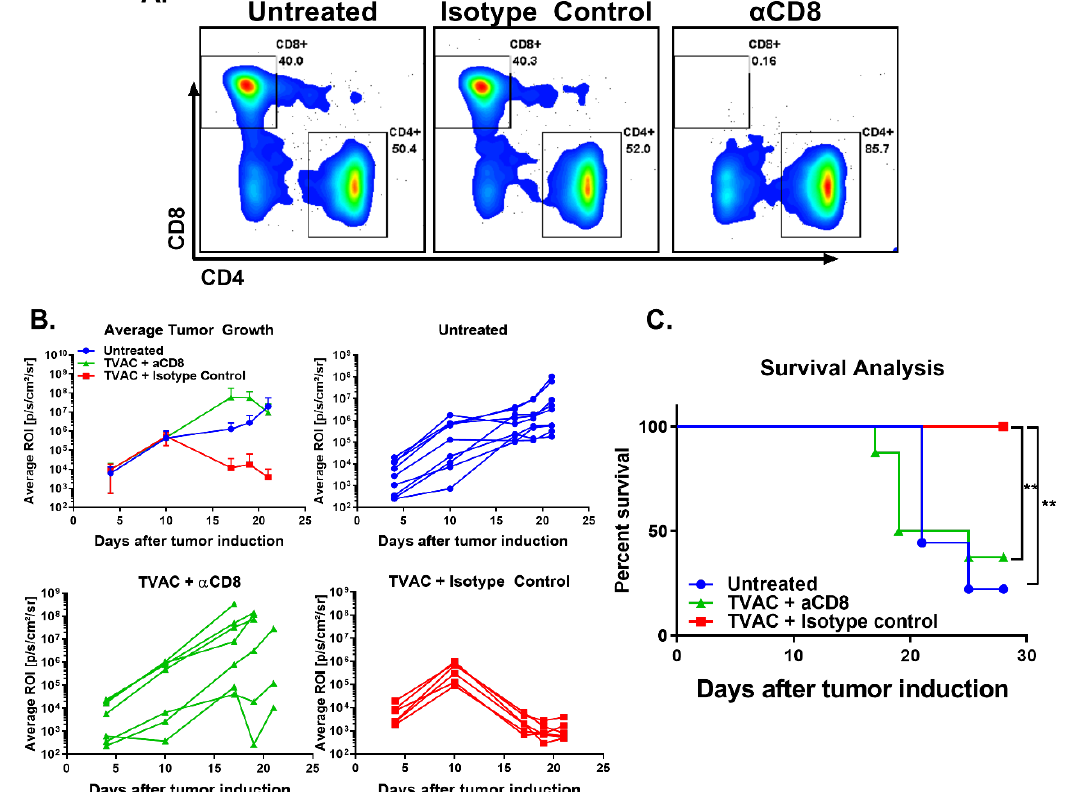
Figure 3. TVAC efficacy is dependent on CD8 T cells. Antibody for the depletion of CD8 T cells was administered by the intraperitoneal route every three days beginning one day prior to tumor induction as described in the methods. Depletion of CD8 T cells in the blood over time was ascertained via flow cytometry and representative flow plots are shown ( A ). Tumor growth and survival were recorded over time ( B , C ). Significance in survival proportions was measured using the log-rank test. p < 0.005 (**).